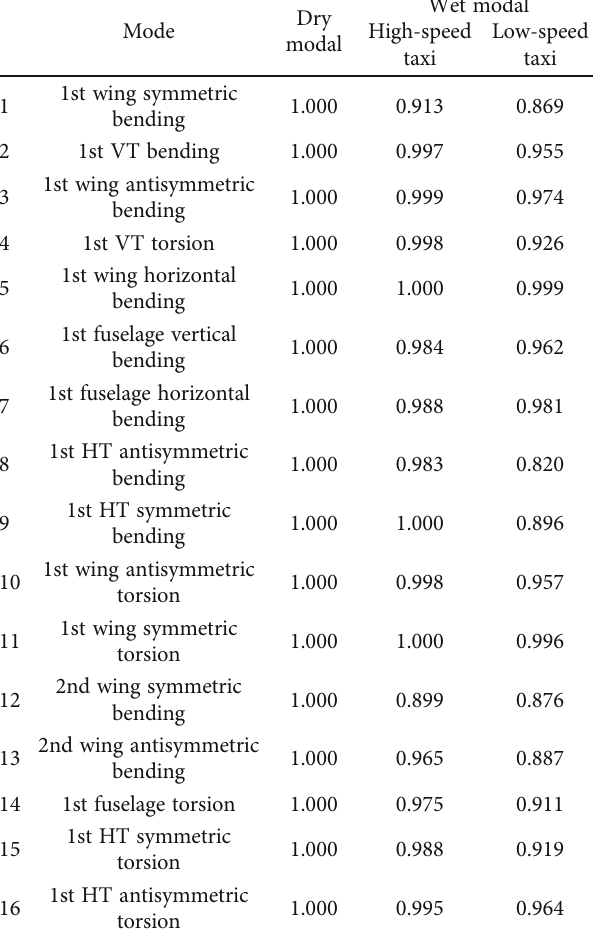
Table 2: Computation of modal frequencies.